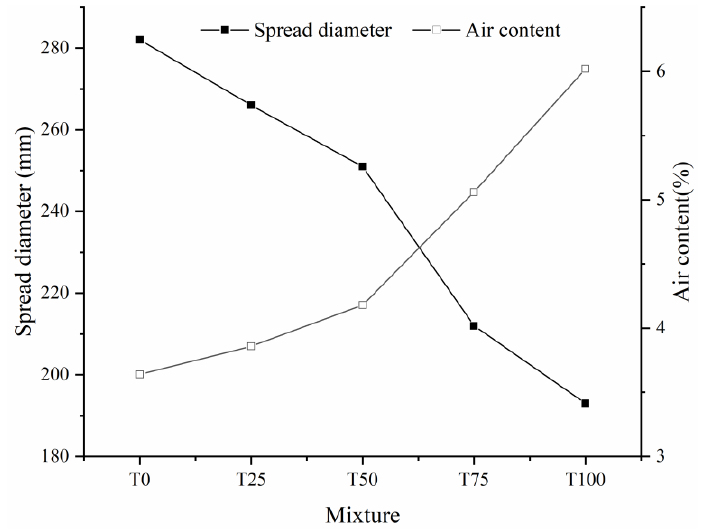
Figure 8. Effect of iron tailings on the workability and air content of UHPC.